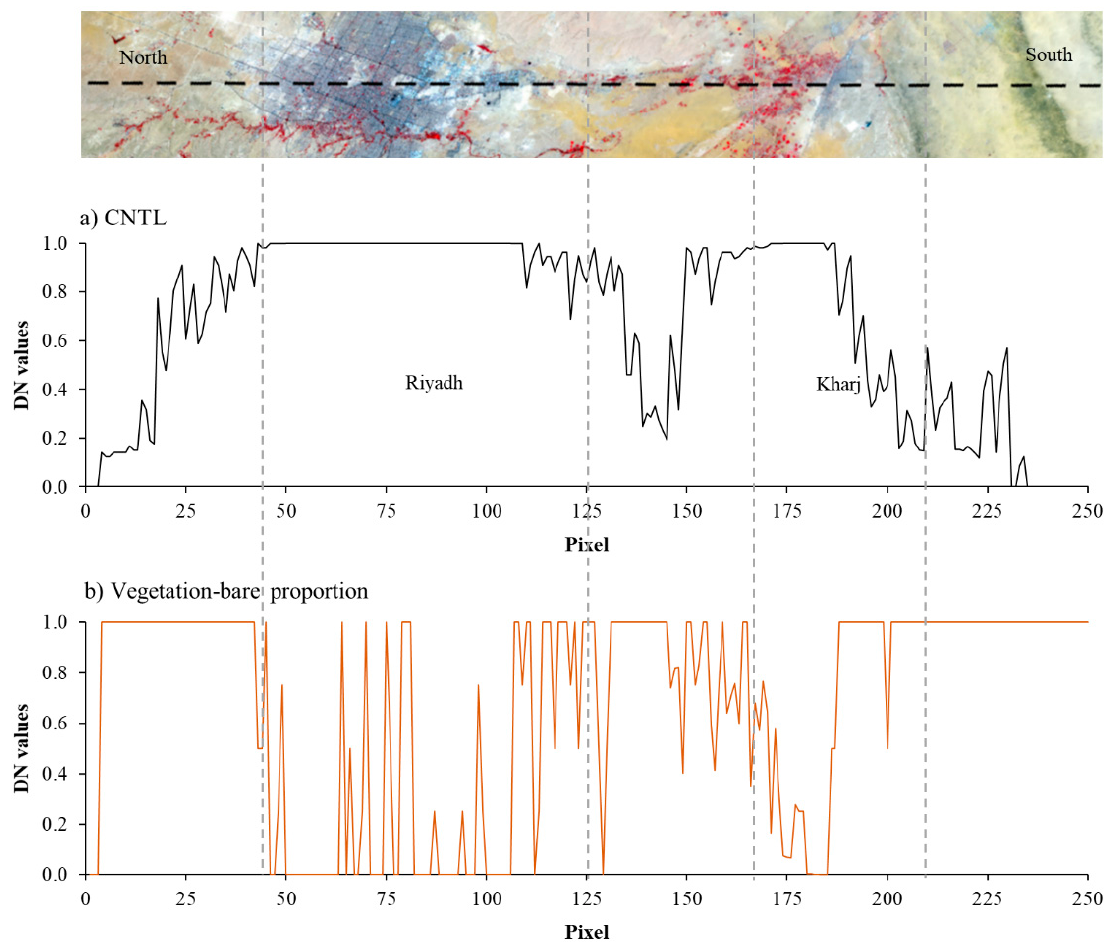
Figure 2. Longitudinal transects of Riyadh and Kharj cities from north to south over ( a ) CNTL and ( b ) vegetation-bare proportion.